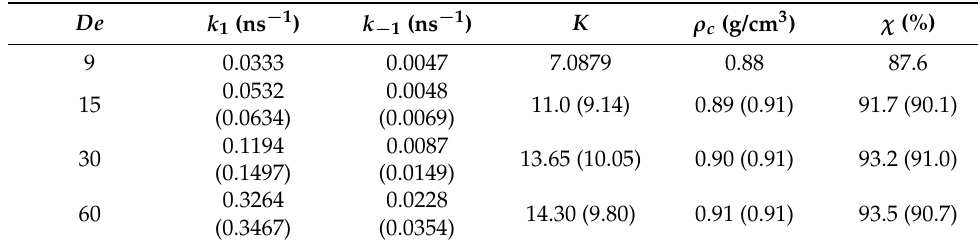
Table 2. Forward ( k 1 ) and reverse ( k 1 ) kinetic rate constants at several De as calculated from the − simulation output. Displayed are the corresponding equilibrium constant, K = k 1 / k 1 , steady-state − density of the semicrystalline phase, ρ c , and degree of crystallinity, χ . Note that tabulated values in parentheses are the rate constants from the PEF simulations obtained from Ref. [18].